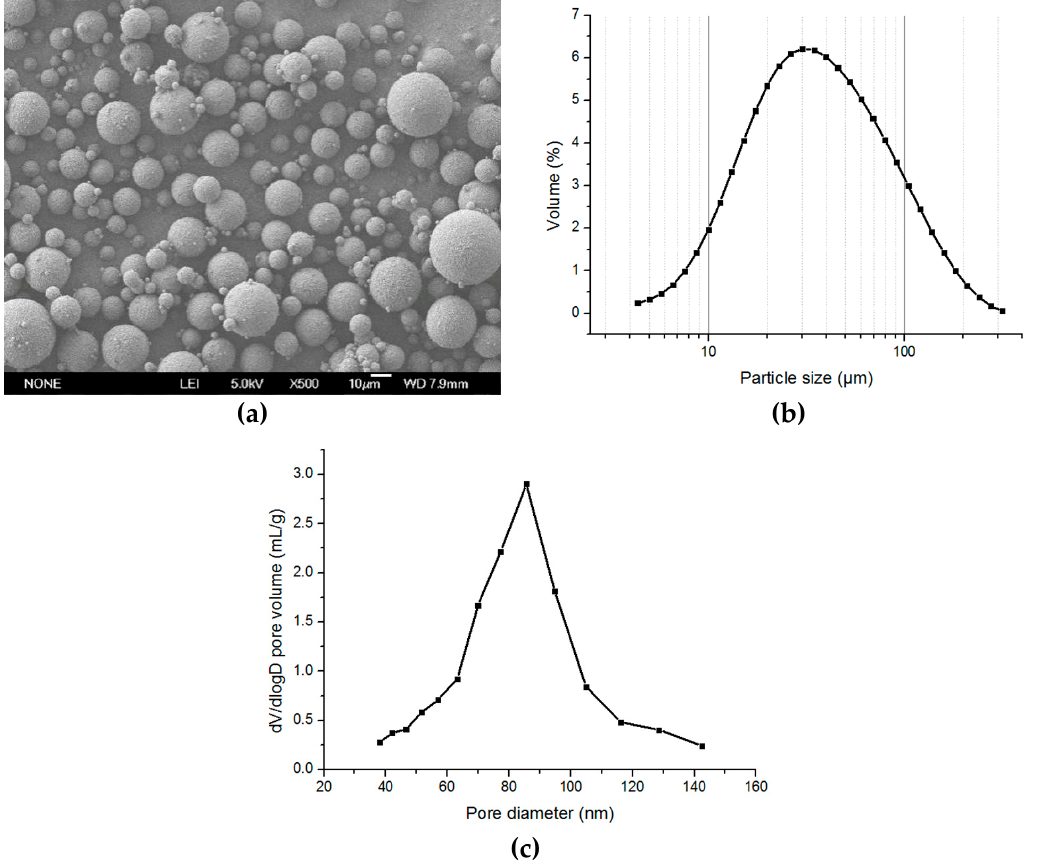
Figure 8. The photographs of the polymer microspheres by screen emulsification ( a ) SEM (×500), ( b )